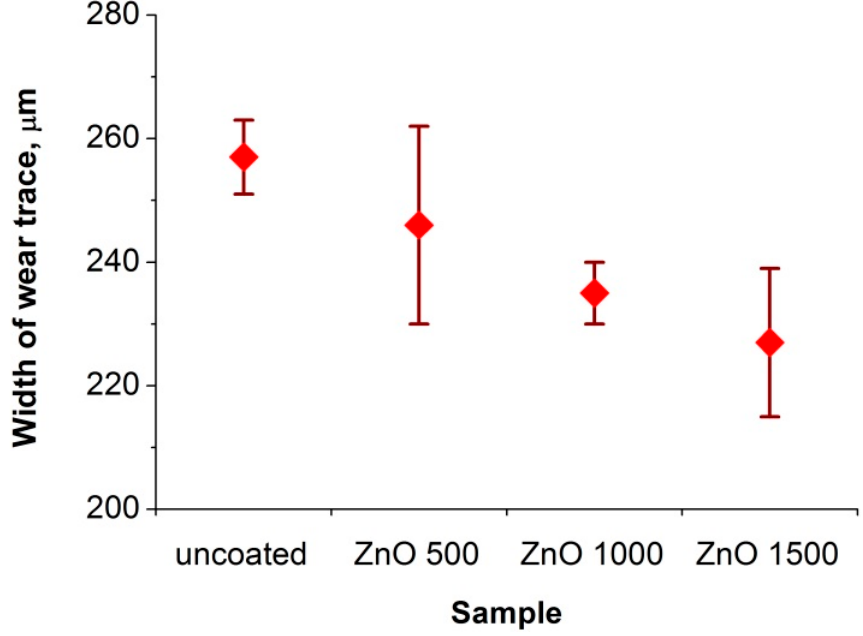
Figure 14. Width of wear trace of the investigated materials.